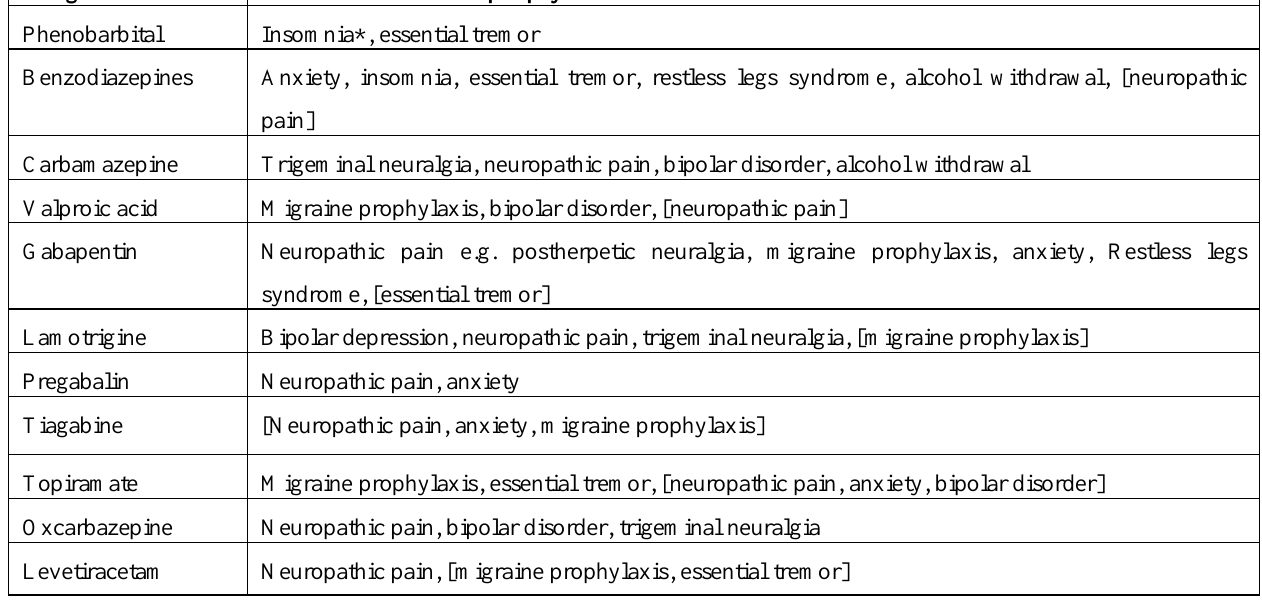
Table 2. Uses of antiepileptic drugs in non-epilepsy